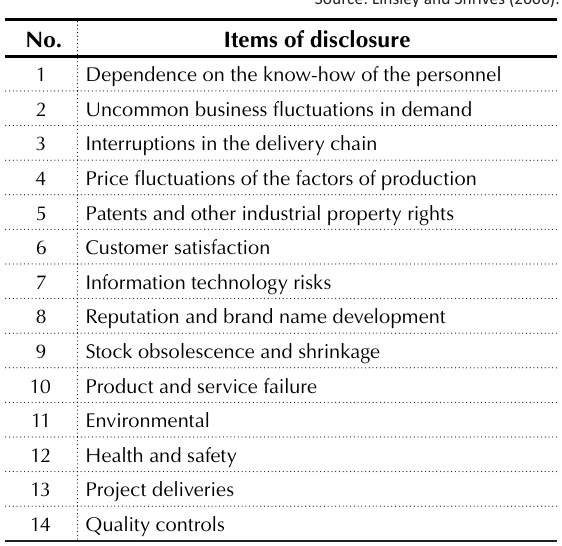
Table 3. Operational risk disclosure